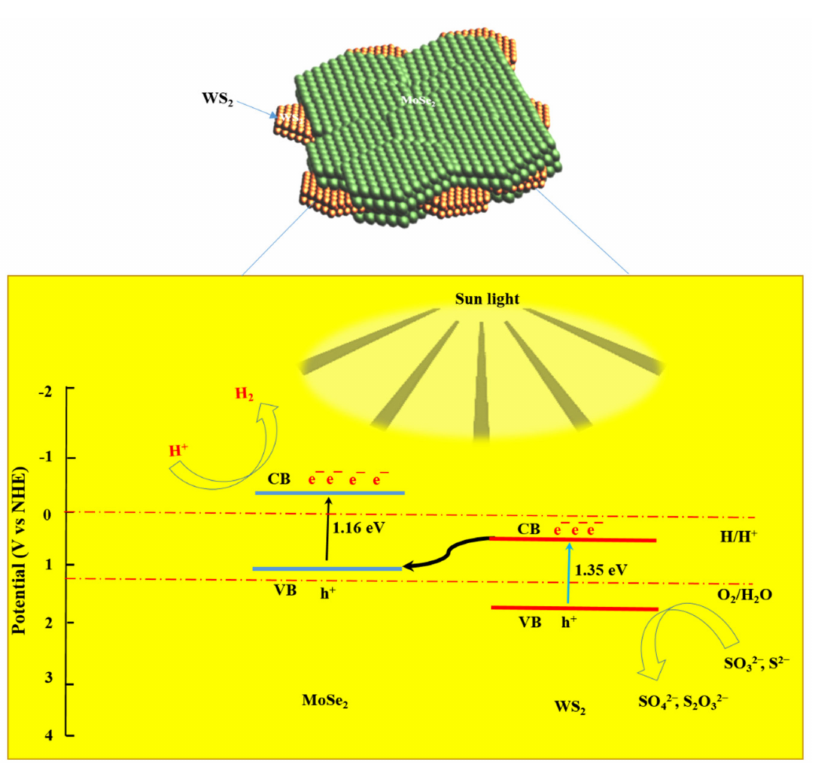
Figure 9. Scheme of the photocatalytic mechanism of MoSe 2 -WS 2 nanostructure under light